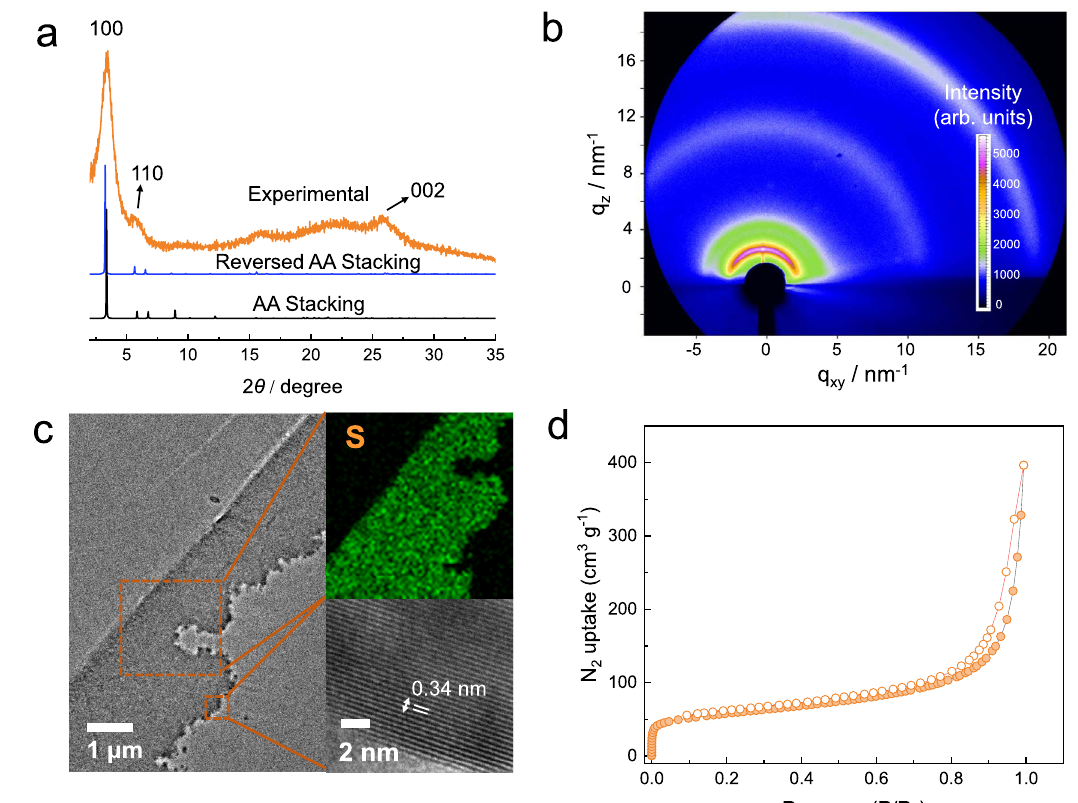
Fig. 2 Membrane characterization. a Experimental PXRD pattern, and simulated PXRD patterns for AA and reversed AA stacking of the TpBD-(SO 3 H) 2 iCOFMs. b GIWAXS pattern of the TpBD-(SO 3 H) 2 iCOFMs. c TEM, EDS, and high-resolution TEM images of the slices of the TpBD-(SO 3 H) 2 iCOFMs. d N 2 sorption isotherms of the TpBD-(SO 3 H) 2